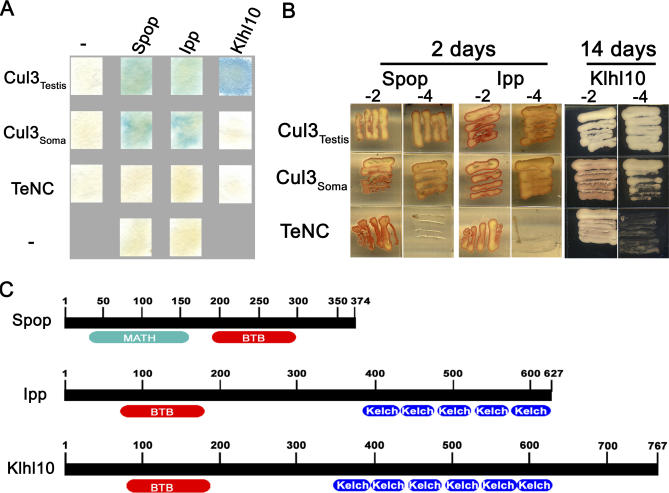
Klhl10, a BTB and Kelch Domains Protein, Preferentially Interacts with Cul3Testis and Not with Cul3Soma
(A) Three BTB-domain proteins, the Drosophila orthologues of Spop, Ipp, and Klhl10, were found to interact with Cul3Testis in a yeast-two-hybrid screen. β-galactosidase filter assay demonstrates that whereas Spop and Ipp can also interact with Cul3Soma, Klhl10 only interacts with Cul3Testis. While the TeNC domain of Cul3Testis is required for this interaction, it is not sufficient to mediate the interaction with Klhl10.(B) Similarly, in a nutrient-omitted medium assay, yeasts with both Cul3Testis and Klhl10 grew rapidly (2 d) on plates that lacked, in addition to leucine and tryptophan (−2), also histidine and adenine (−4 plates). However, yeast with Klhl10 and Cul3Soma grew very poorly on −4 plates. Even after two weeks of incubation, the colony is only partially established. Note that the results for the auxotrophy rescue of Klhl10 are shown not after 2 d but rather after 14 d in order to reflect the weak interaction between Klhl10 and Cul3Soma.(C) Schematic representations of Spop, Ipp, and Klhl10, and the relative locations of their major domains. The BTB-domains of all these proteins are sufficient for binding to Cullin-3.